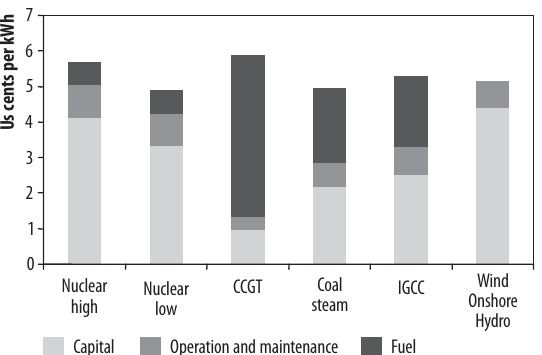
Figure 1. Power generation costs, US cent/kWh